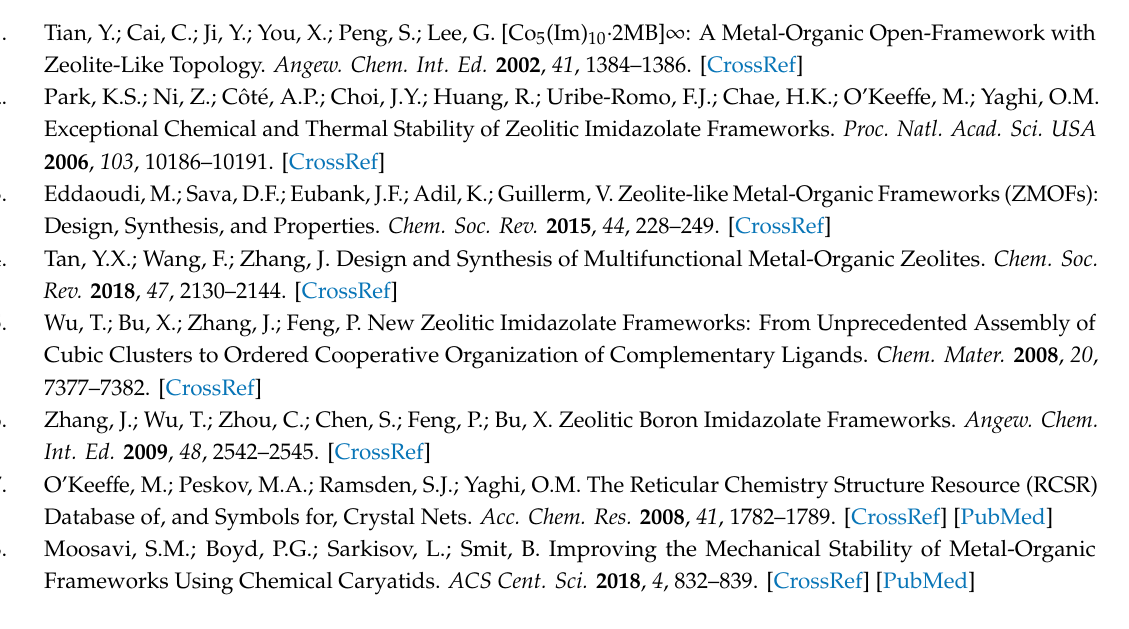
Supplementary Materials: Full details of all experimental procedures, assigned 1 H-NMR spectra, detailed PXRD patterns for all prepared materials, and sorption analysis details for 0.2 MeMeCH 2 @RHO-Zn 16 ( Cl 2 Im ) 32 and RHO-Zn BIm 2 are available